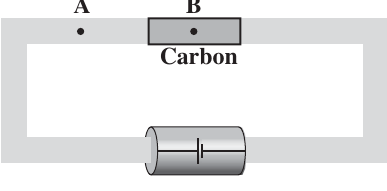
FIG. 1. A simple circuit with a carbon